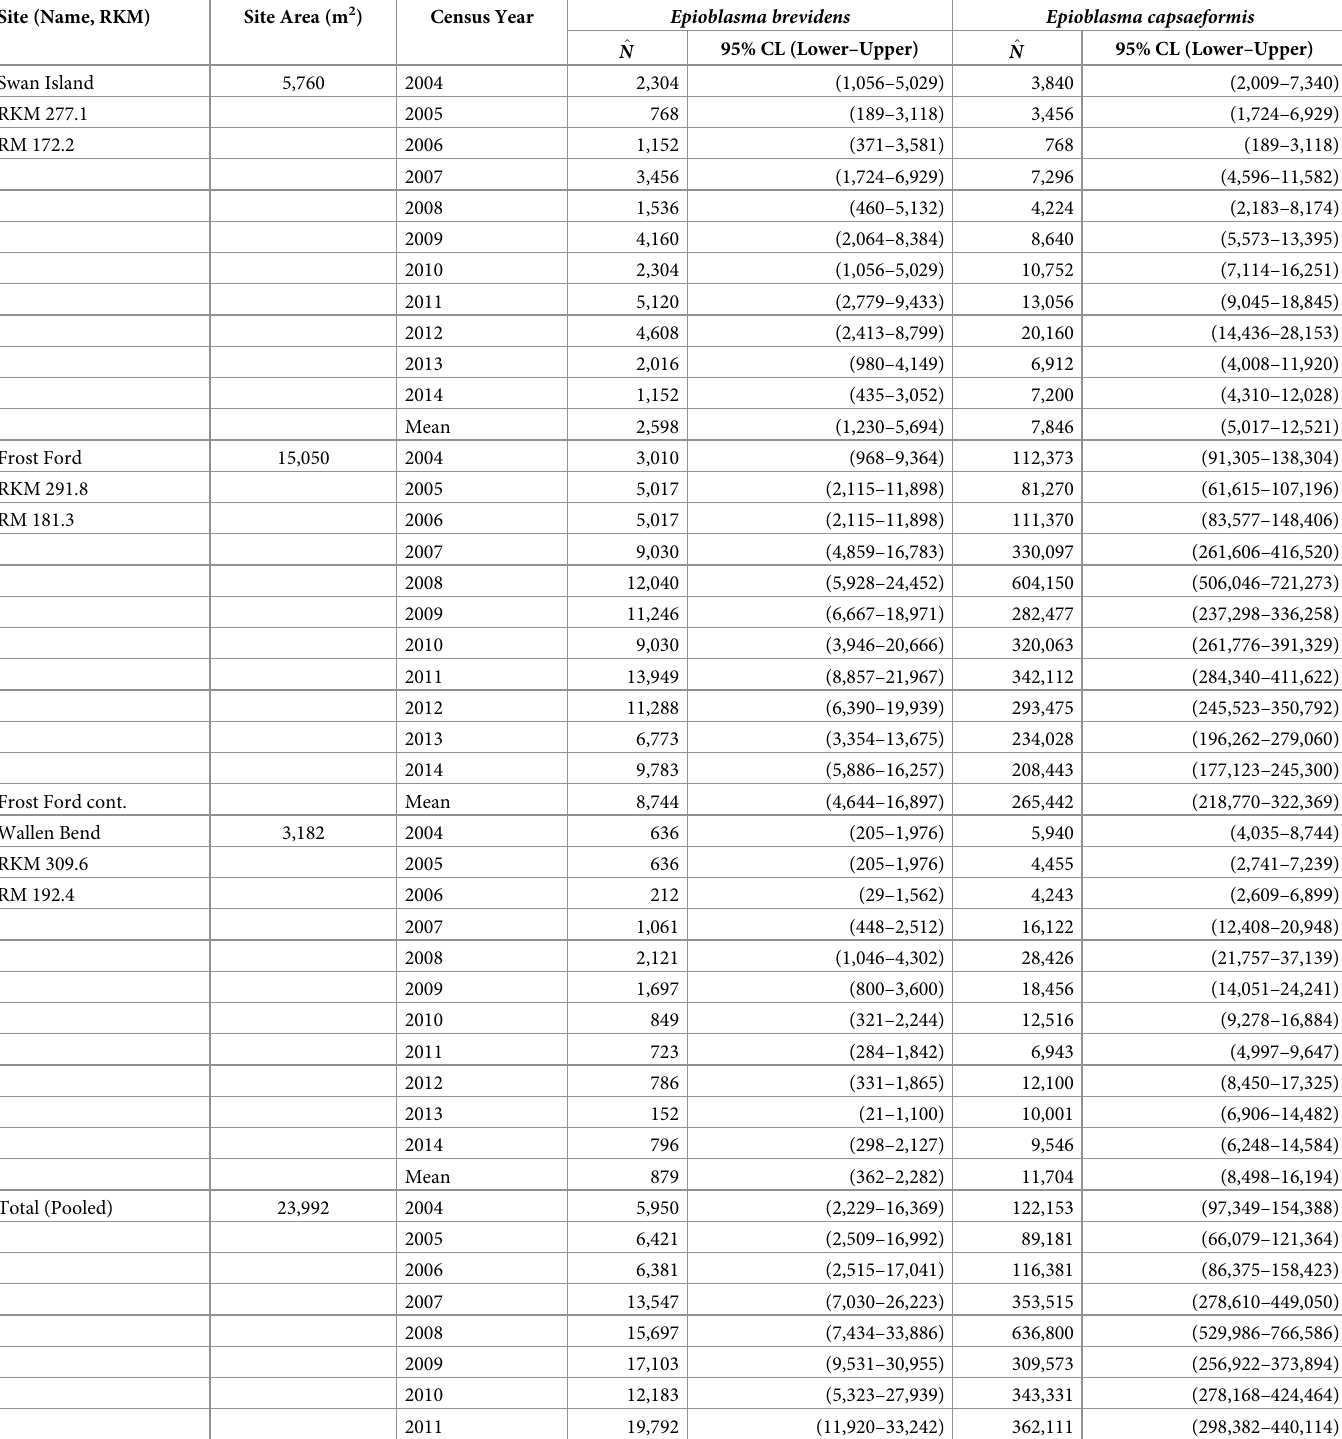
Table 2. Estimates of site-specific and total (pooled) population sizes for Epioblasma brevidens and E . capsaeformis for each annual census conducted in the Clinch River, TN from 2004–2014. Population size ( ^ N ) per site was obtained by multiplying mussel density ( ^ D ) values in Table 1 by the site square area measured in square meters (m 2 ). RKM = River Kilometer, RM = River